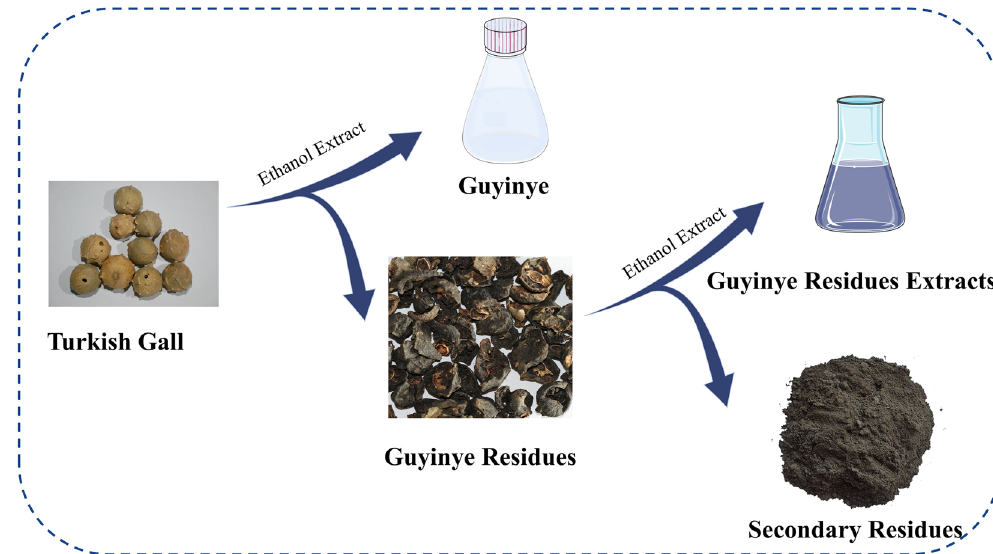
Fig.1 Source of raw